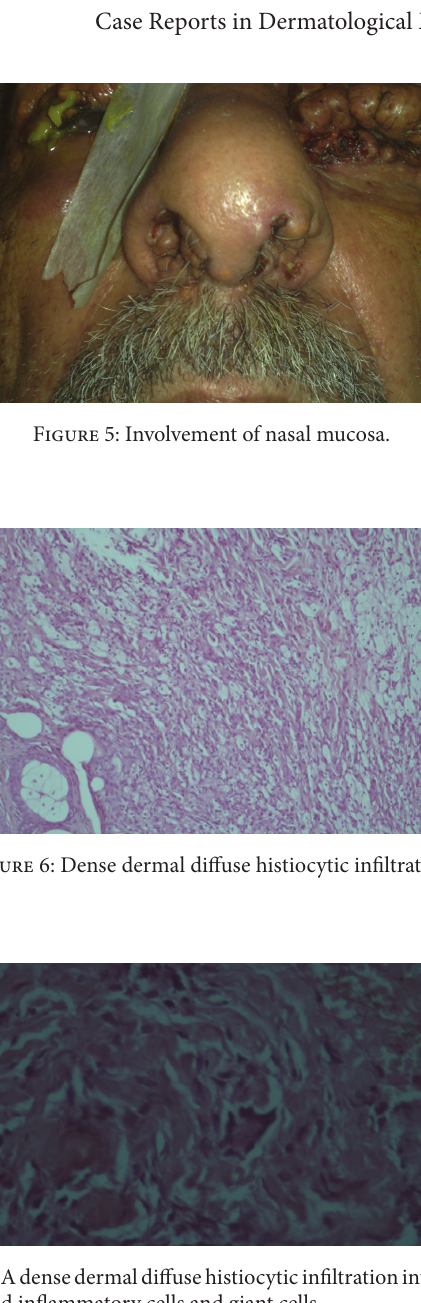
Figure 3: Involvement of red-brown papules.